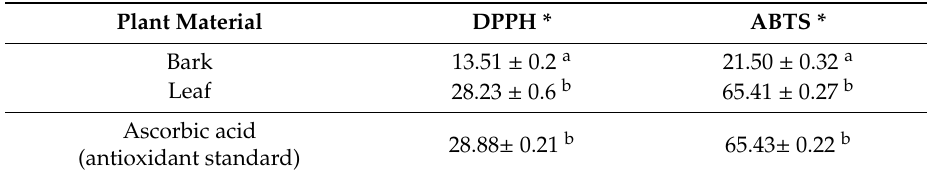
Table 2. In vitro antioxidant activities in DPPH and ABTS assays of S. alba hydromethanolic leaf and bark